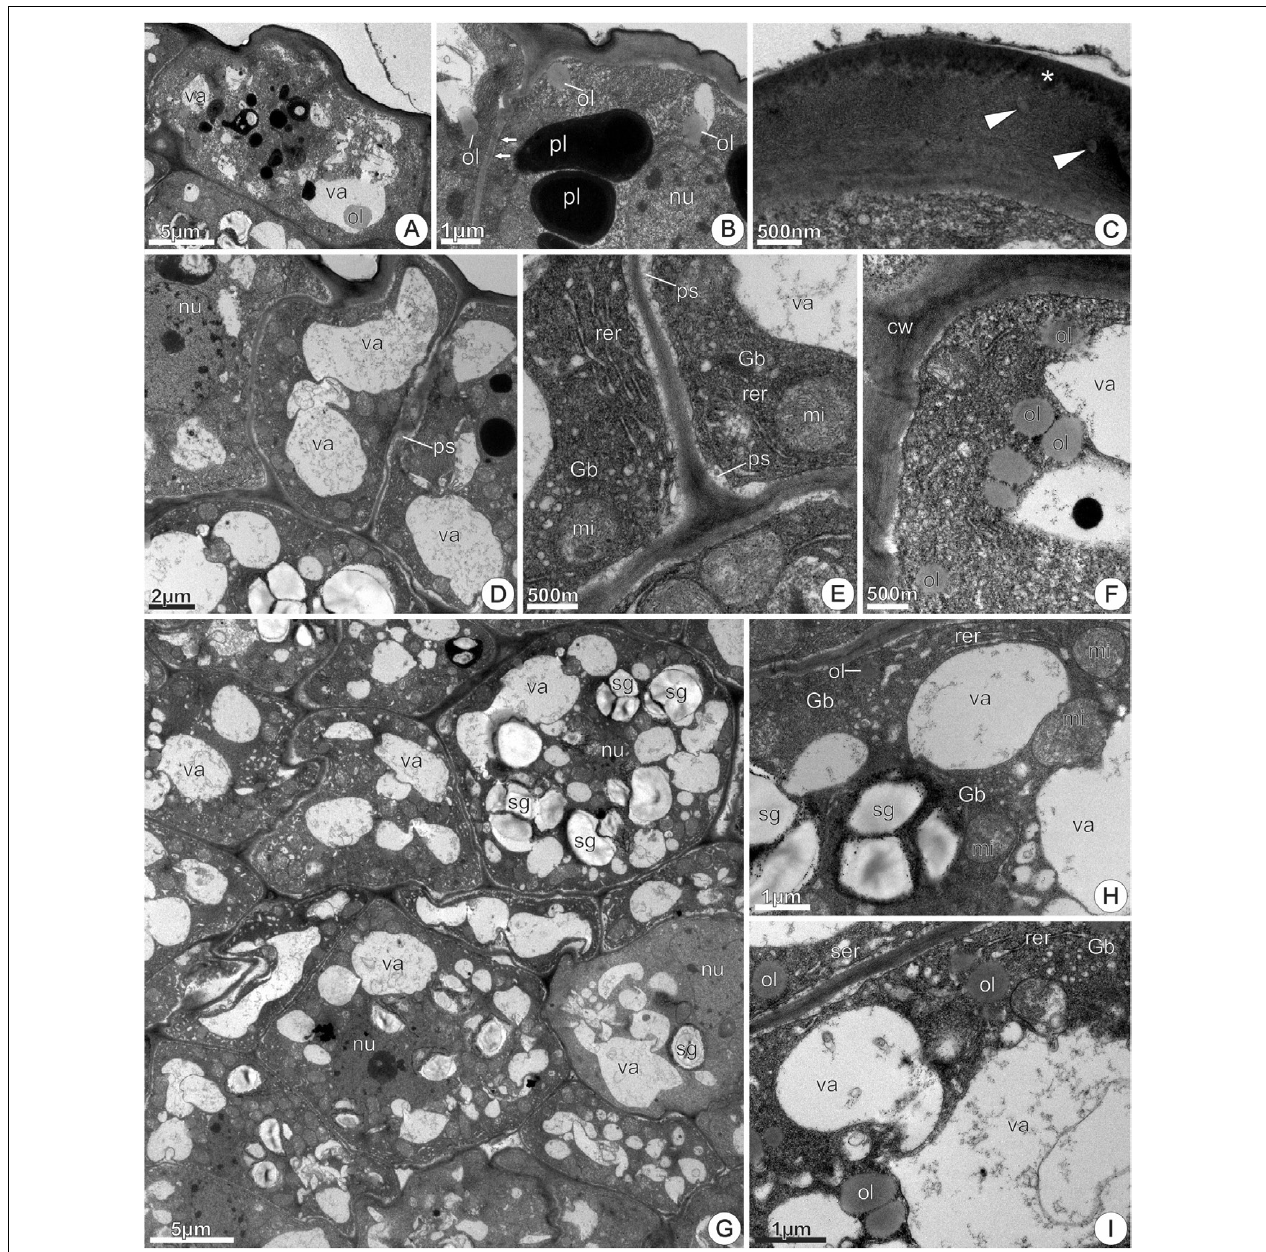
FIGURE 8 | TEM micrographs of the disk from Jacaranda oxyphylla nectariferous flowers, at 0 h of anthesis. (A–F) Epidermal cells. (A) Rectangular cells with cytoplasm and vacuoles with heterogeneous inclusion; (B) plasmodesmata (arrows), conspicuous nucleus, abundant cytoplasm with dense plastids and oil drops; (C) detail of the outer tangential cell wall highlighting oil inclusions (arrow heads) embedded in the wall matrix and osmiophilic deposits (asterisk) in the cuticular layer; (D) conspicuous nucleus, developed vacuoles, sinuous plasmalemma, and small periplasmic spaces; (E) detail of (D) showing abundance of organelles in the peripheral cytoplasm and flocculent materials inside vacuole and periplasmic space ; (F) polyribosomes through the cytosol and oil bodies adjacent to tonoplast. (G–I) Nectary parenchyma. (G) General aspect showing cells side by side with different ultrastructure; (H) detail of (G) showing amyloplasts with residual starch grains and RER profiles assembled around degenerating amyloplasts and vacuoles; (I) vacuoles with flocculent materials and membrane debris, hyperactive Golgi body, enlarged SER elements and oil drops. Gb, Golgi body; mi, mitochondria; nu, nucleus; ol, oil; pl, plastid; ps, periplasmic space; rer, rough endoplasmic reticulum; ser, smooth endoplasmic reticulum; sg, starch grains; va, vacuole.